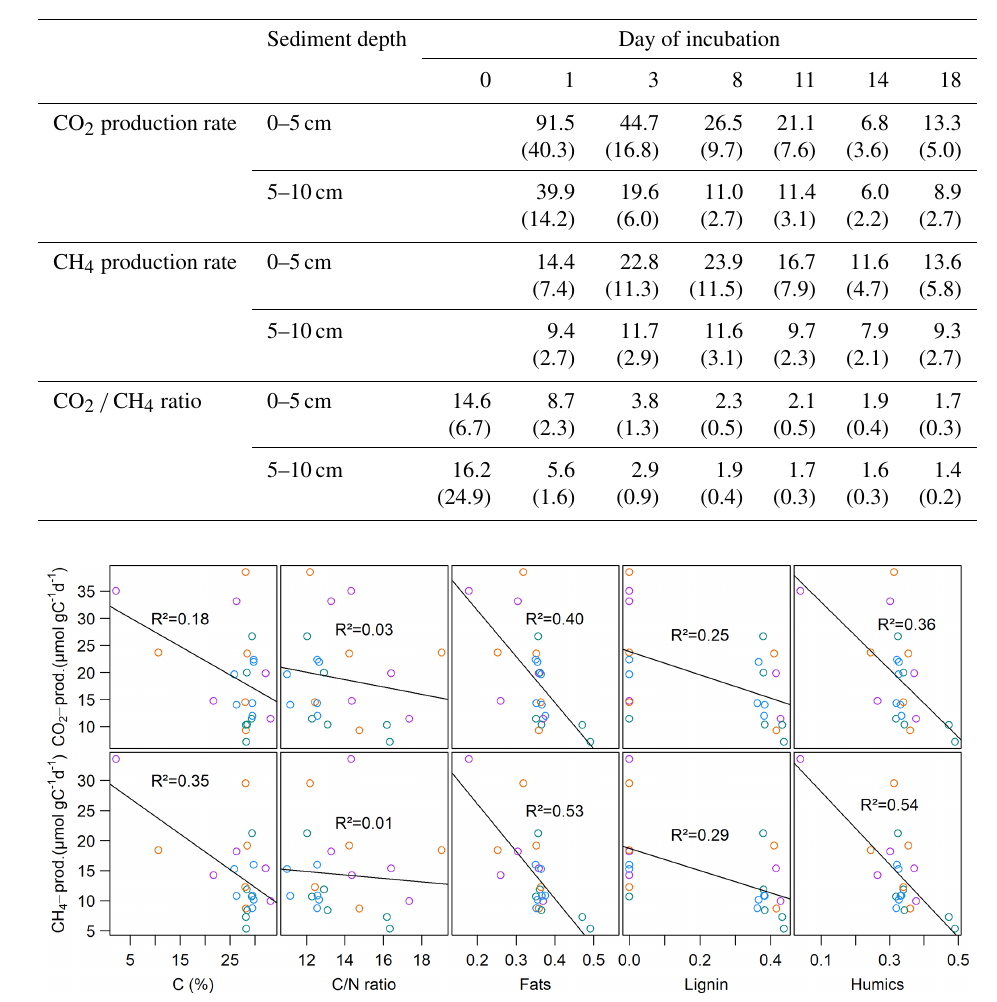
Table 3. CO 2 and CH 4 production rates and the CO 2 / CH 4 amount ratio over time (rates in µmolgC − 1 d − 1 ; ratios in µmol). Values in brackets are standard deviations.